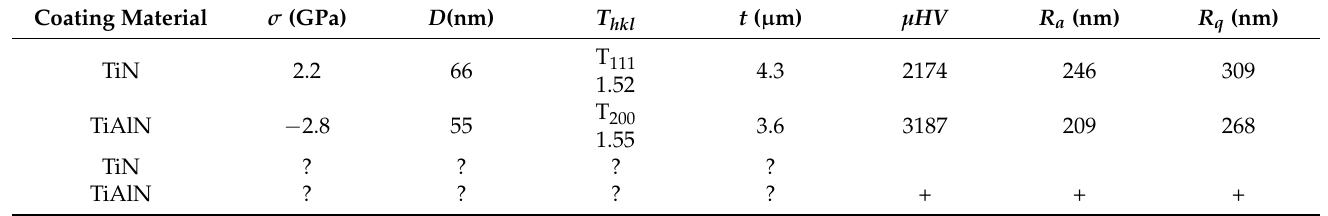
Table 6. The summarized characteristics of the TiN and TiAlN coatings and the assigned marks: “+” for the better values and ”?” for indiscriminate